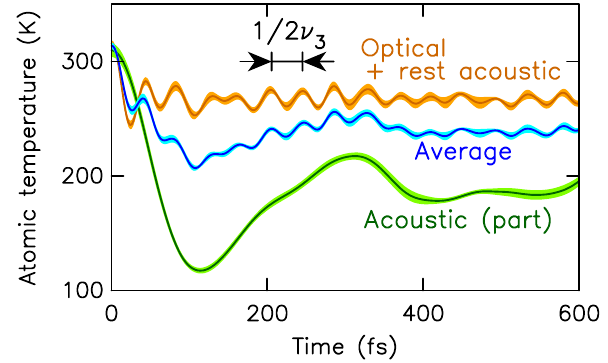
FIG. 3. Total and spectrally projected instantaneous atomic temperatures as a function of time after femtosecond-laser excitation. The data used and the decomposition are the same as in Fig.